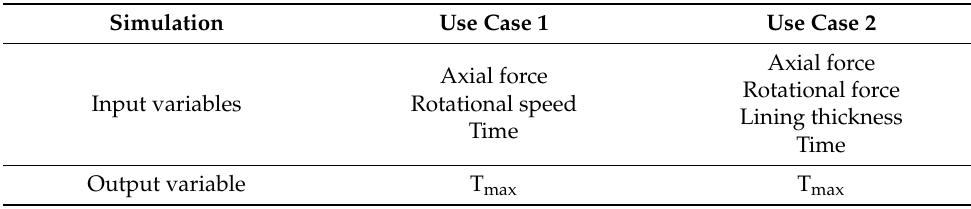
Table 3. Input and output variables of the respective use